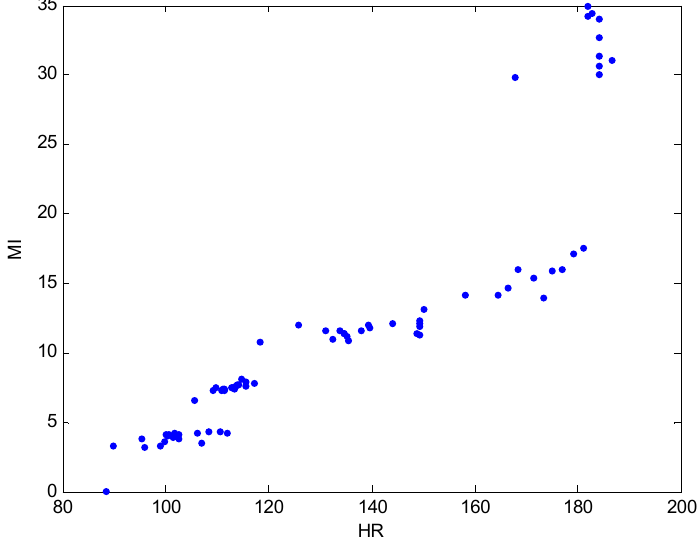
Figure 3. Example of data distribution during treadmill